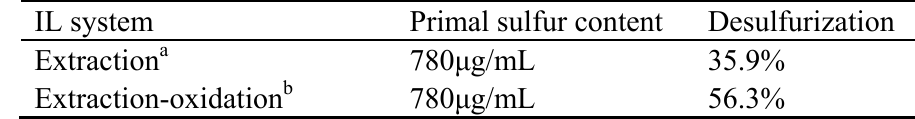
Table 1. Effect on desulfurization in diesel oil.